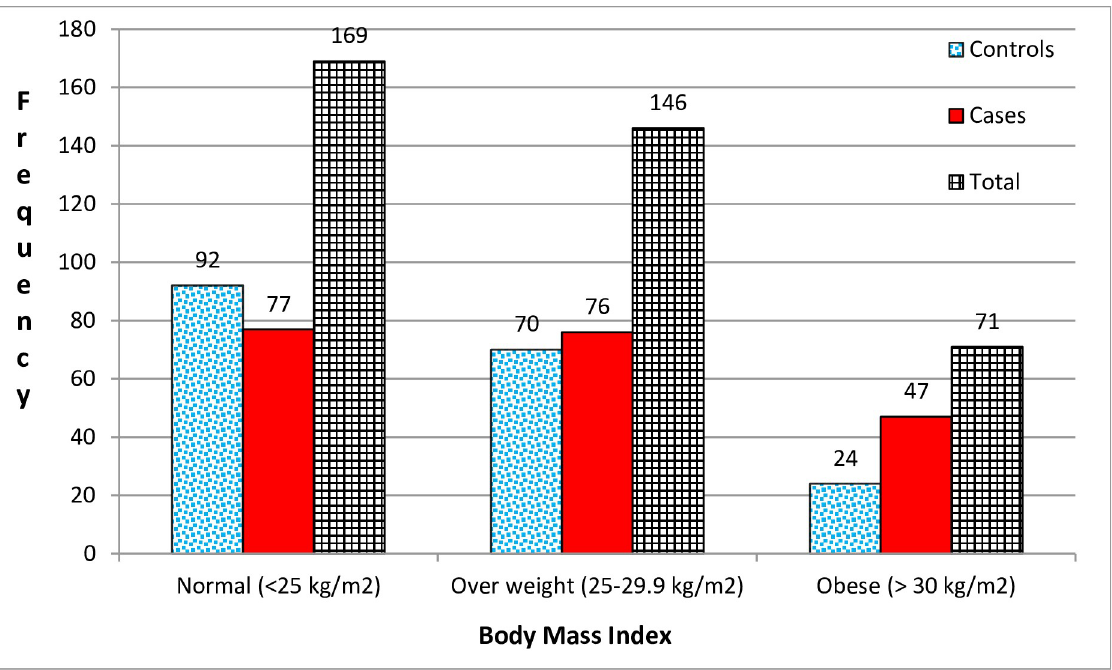
Fig 1. Distribution of hypertensions by BMI status among people with T2DM on follow-up at TASH hospital, Addis Ababa, Ethiopia, 2020.